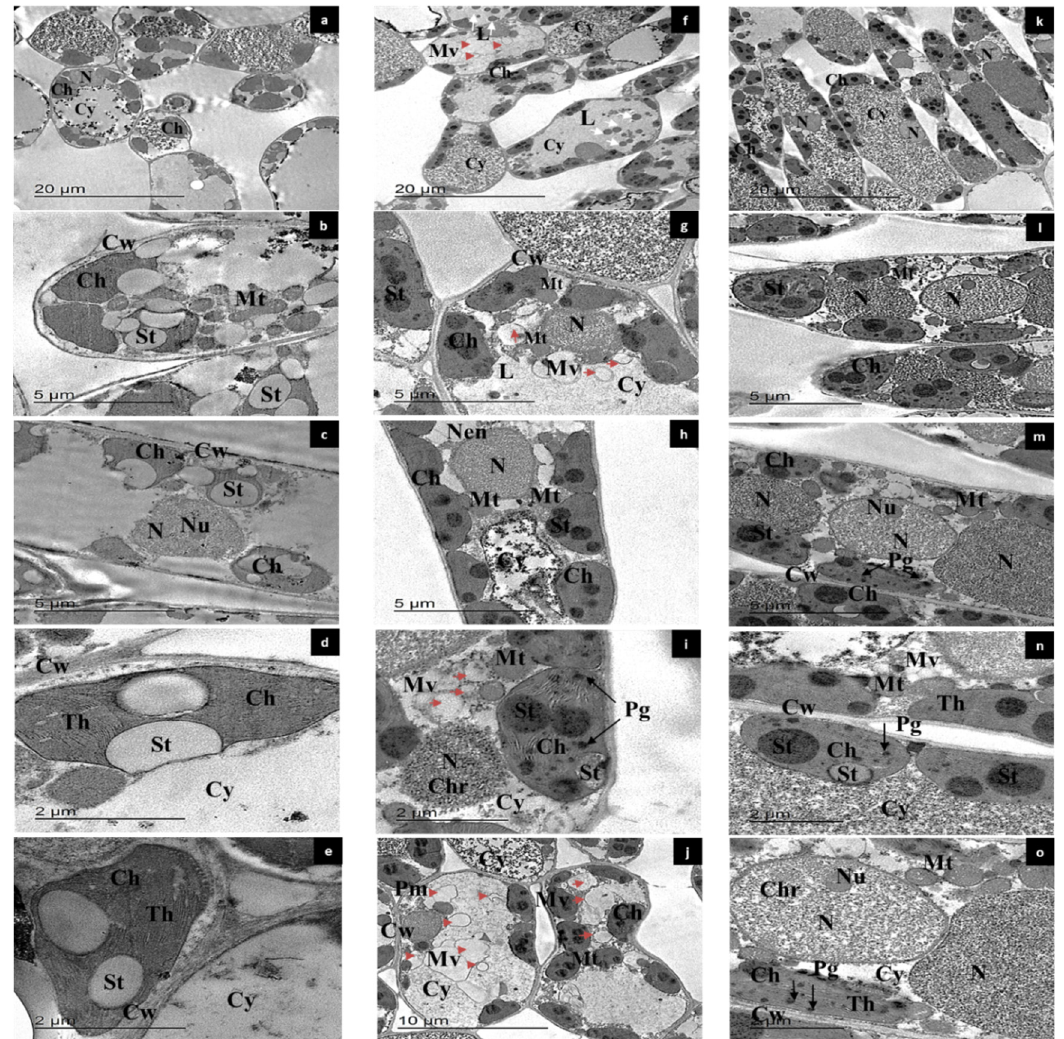
Figure 5. TEM micrograph of mesophyll cells of grapevine leaf, showing alternation in the ultrastructure of cell organelles including chloroplast, nucleus, mitochondria, and cell wall as well as the plasma membrane. ( a – e ) (control, T1); ( f – j ) (severe salinity, T8), ( k – o ) (severe salinity plus 2 mg L − 1 BL foliar spraying, T10). An overview and details of control cells: ( d , e ) showing well-organized chloroplasts with smooth cell walls; ( c ) dispersion of nucleolus and chromatin in nucleus matrix and continuous nuclear envelope; ( b ) soft and thin cell wall with numerous mitochondria; ( f , j ) an overview of salt-affected cells indicating devastation of cell organelles, and a decrease in the size of chloroplast and accumulation of lipid droplets in the cytoplasm (white arrows) as well as an increase in the membrane vesicles (red arrows); ( g ) showing membrane vesicles (red arrows), and nucleus appeared without nucleolus; ( h , i ) swelling chloroplast with dilations of the thylakoid granum, and an increase in starch grains and plastoglubouline; ( k ) an overview of mesophyll cells in T10; ( i , m , o ) mesophyll cell having a well-organized nucleus, smooth nuclear envelop, mitochondria; ( n ), well-organized chloroplasts. (TEM, transmission electron microscopy; Ch, chloroplast; N, nucleus; Cy, cytoplasm; Cw, Cell wall; Mt, mitochondria; St, starch grain; Nu, nucleolus; Th, thylakoid; L, lipid droplets; Mv, membrane vesicles; Chr, chromatin; Pg, plastoglubouline; Nen, nuclear envelope; Pm, plasma membrane).